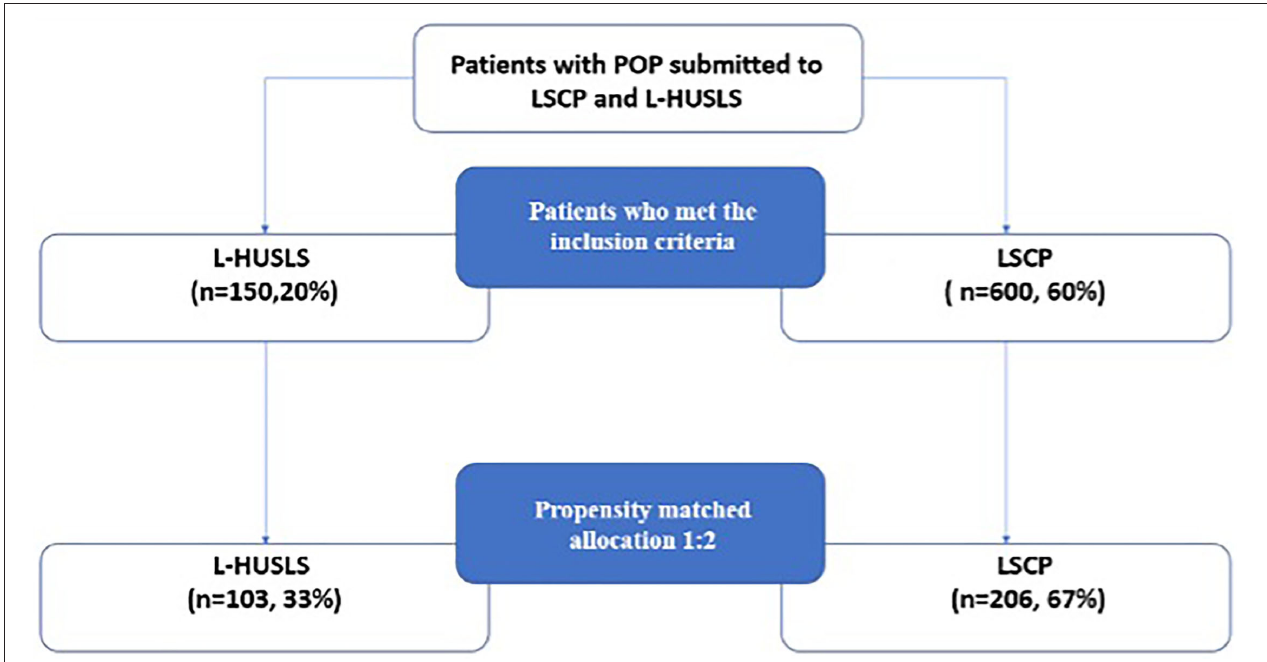
FIGURE 1 | Study design and selection process. In the period from 2015 to 2018, patients in the Control group and 150 patients in the Case Group were enrolled. Because of the nonrandomized nature of the study design and the possible allocation biases arising from the retrospective comparison between groups, we performed a propensity matched analysis. LSCP, laparoscopic sacral colpopexy; L-HUSLS, laparoscopic high uterosacral ligament